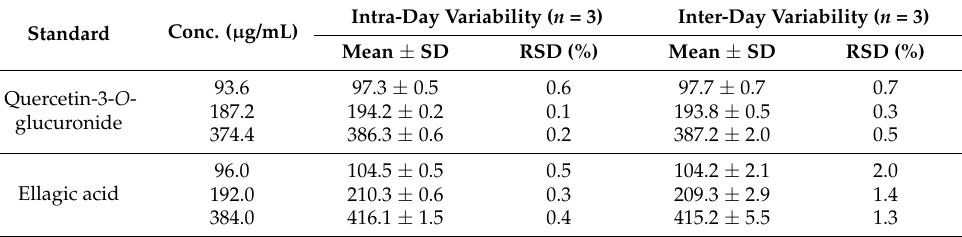
Table 2. Intra-day and inter-day variabilities of quercetin-3- O -glucuronide and ellagic